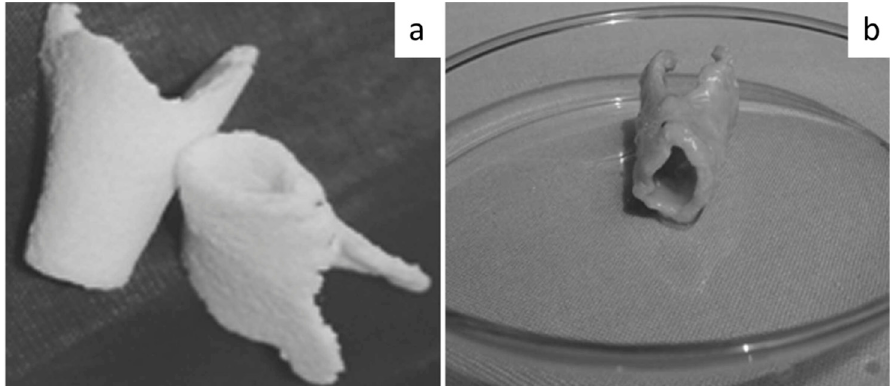
Figure 11. Experimental PHAs applications for cartilage tissue engineering. ( a ) Representation of a PHBH medical device prepared by solvent casting, compression molding, and particulate filtering, with a final hollow semi-flared shape, which intends to mimic the laryngeal cartilage morphology (adapted from Reference [154]). ( b ) Photograph of the laryngeal cartilage PHBH specimen with chondrocytes inoculated, 18 weeks after implantation (adapted from Reference [154]).